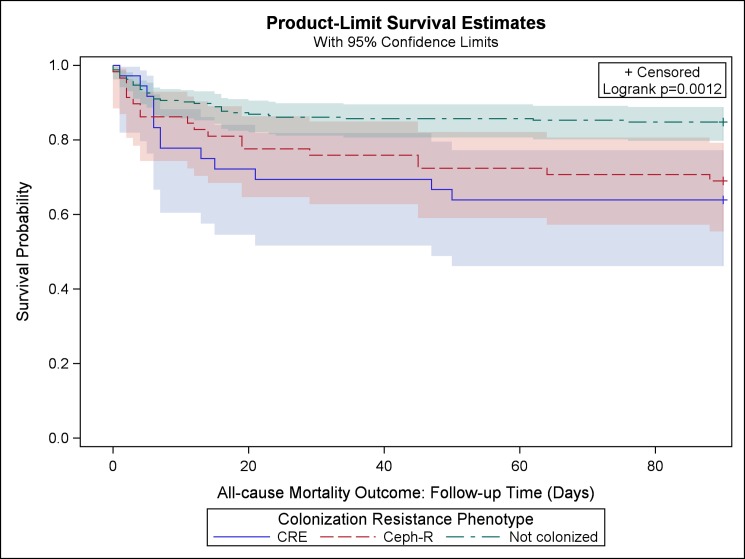
Kaplan-Meier estimates (and 95% confidence limits) of the survival probability for all-cause mortality, 90 day follow up.